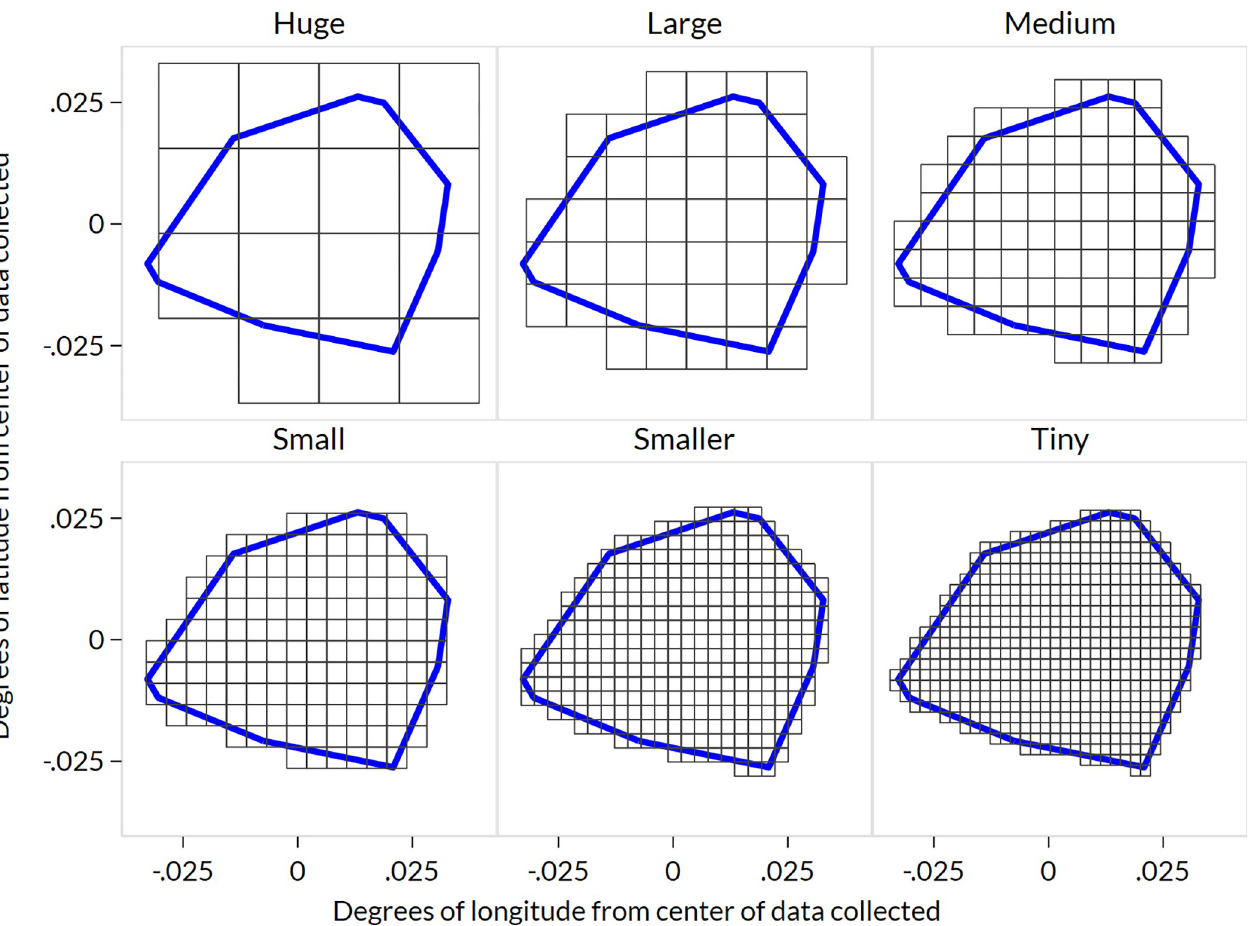
Fig 1. Pseudo-EA sizes in medium urban site in Kenya. Pseudo-EAs are depicted as black squares, while the CM4FP study site pseudo-boundary is depicted in blue. In each study site, six pseudo-EA sizes were created, ranging from huge (three entire EAs fit across the study site) to tiny (24 EAs fit across the study site), with the same ratios being used to define these categories of pseudo-EA for each study site. Because the study sites vary in area and population, the geographic footprint and estimated average population of these pseudo-EA sizes also vary across study